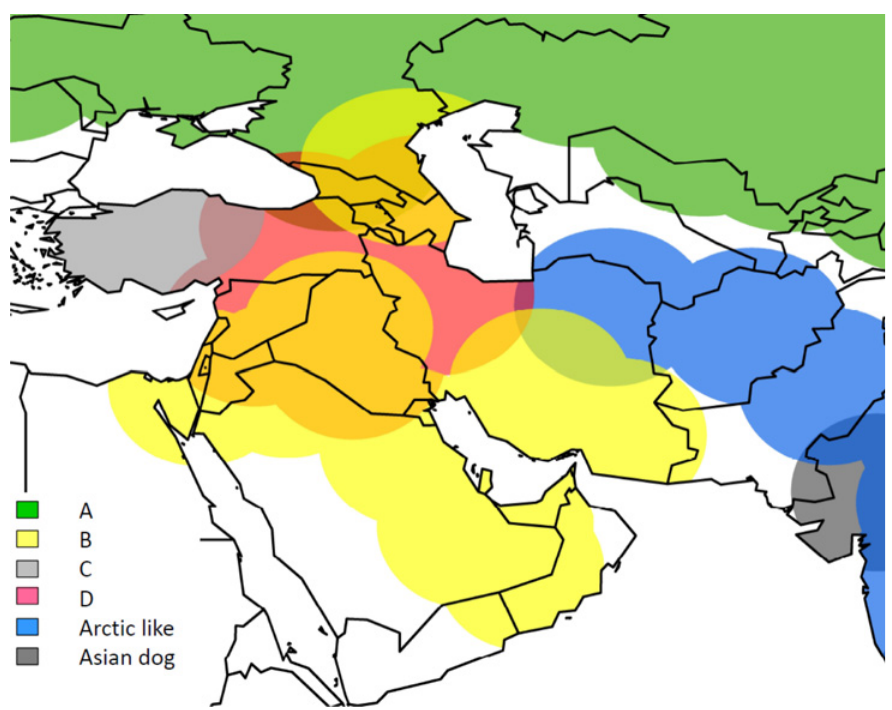
Fig 4. Map showing distribution of virus variants in Middle East, with clades coloured according to Fig. 1. Approximate distribution of each detected RABV lineage is displayed using ArcGis (ESRI ArcGis version